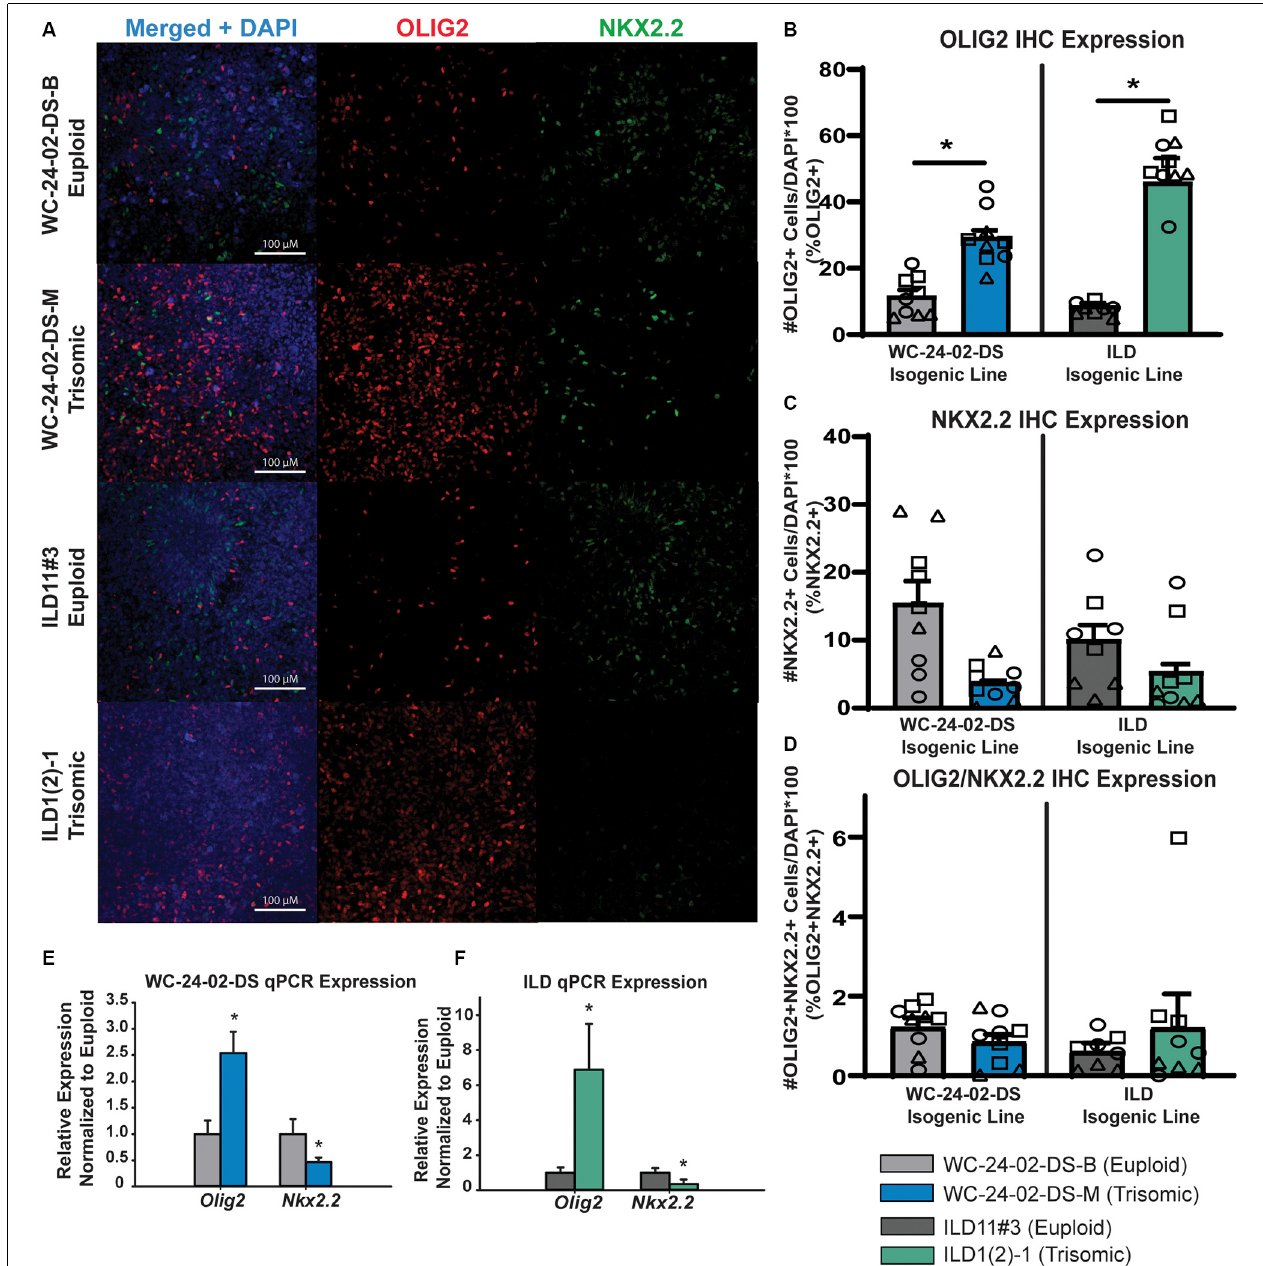
FIGURE 3 | Rostral patterned tNPCs show an altered response to SHH activation. (A) Both isogenic pairs of cells lines (WC-24-02-DS and ILD) differentiated with Wnt-C59 express OLIG2 and NKX2.2 in tNPCs after 4 days of treatment with SAG, an SHH pathway agonist. (B) In both isogenic pairs, the trisomic line (WC ts and ILD ts ) has a significantly higher percentage of OLIG2+ cells in the culture. (C) In both isogenic pairs, the trisomic line (WC ts and ILD ts ) shows a trend for a lower percentage of NKX2.2+ cells in the culture. (D) There is no difference in the percentage of cells co-expressing OLIG2+ and NKX2.2+ between euploid and trisomic lines in either isogenic pair, n = 3, three independent differentiation experiments for all IHC measurements with values for individual wells overlaid. Data is shown as mean ± SEM. (E,F) qRT-PCR measures significantly more OLIG2 expression in the trisomic tNPCs and significantly less NKX2.2 expression in the trisomic tNPCs, n = 3–5 independently cultured wells. * p -value < 0.05 with specific values in